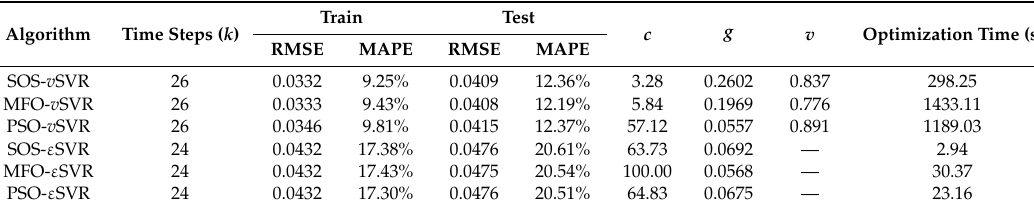
Table 2. Prediction results of v SVR and ε